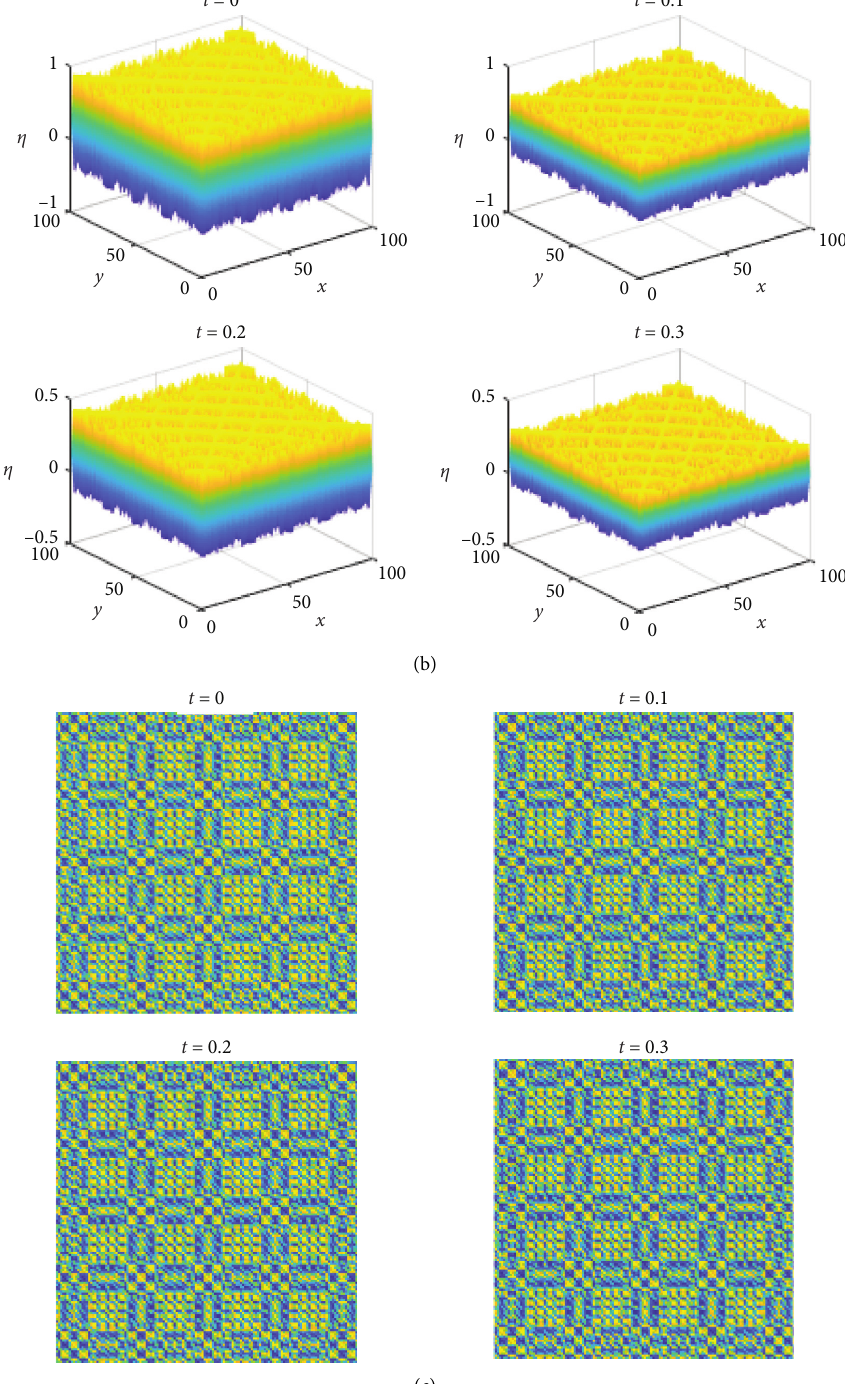
Figure 6: Numerical solution and pattern of Experiment 1 with initial condition η ( x,y, 0 ) � 0 . 8 sin ( cos ( y 2 − x 2 )) + 0 .